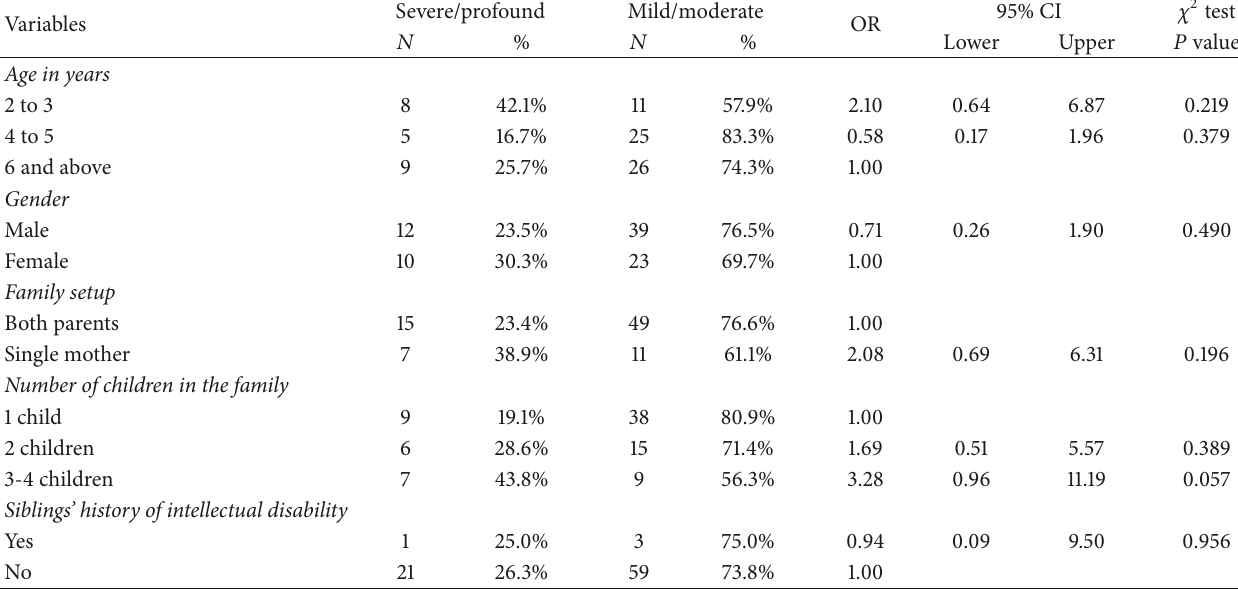
Table 3: Relationship between sociodemographic characteristics of children and severity of intellectual disability.